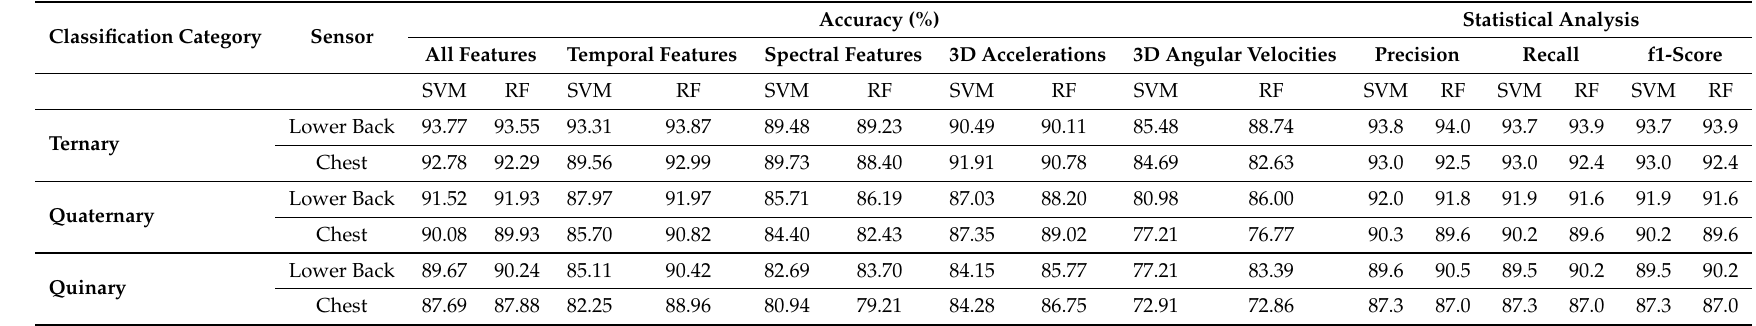
Table A1. Classification results of ternary and quaternary classification for each sensor location. The classification results are presented for each feature set and statistical scores are presented for the set of all features